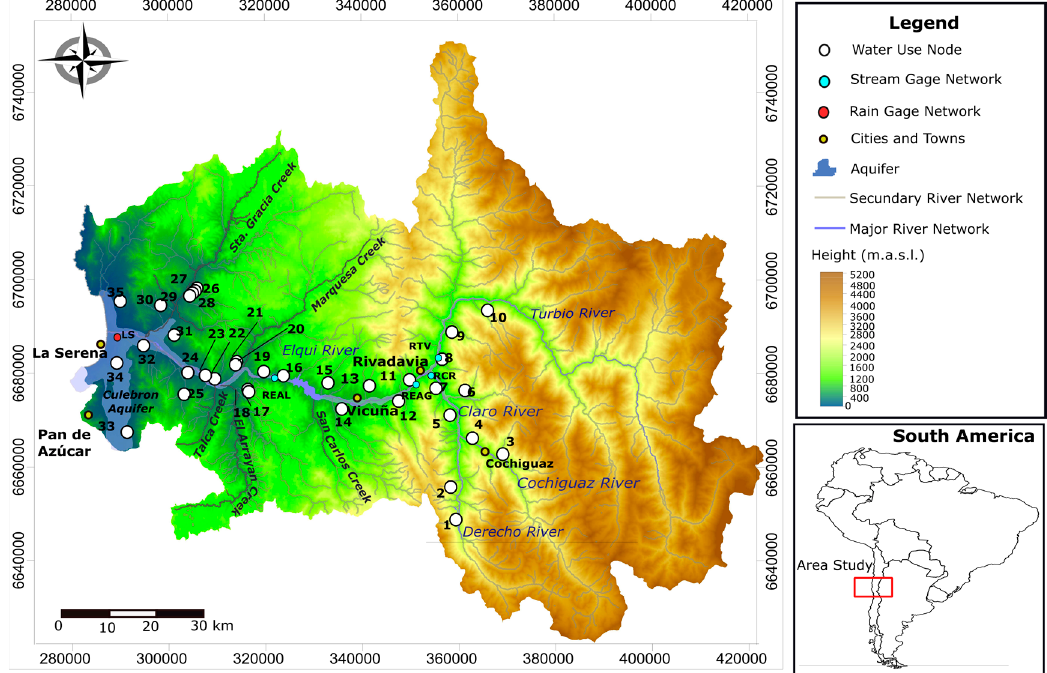
Figure 3. Study area location with rain and stream gauge network. Also shown are points and places of interest. White circles with adjacent numbers refer to nodes of the Water Evaluation and Planning System (WEAP)-Elqui model (Section 2.2.2).